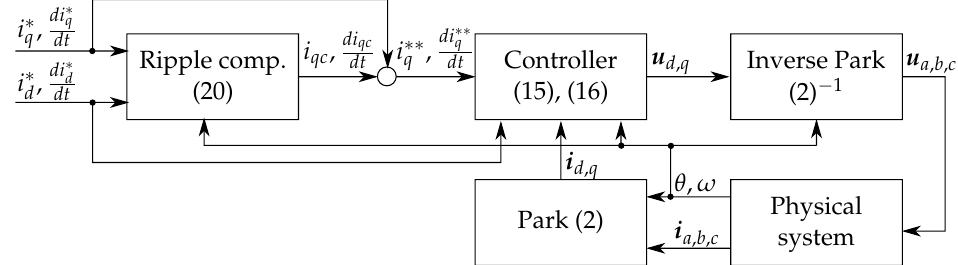
Figure 4. Block diagram of the closed-loop control